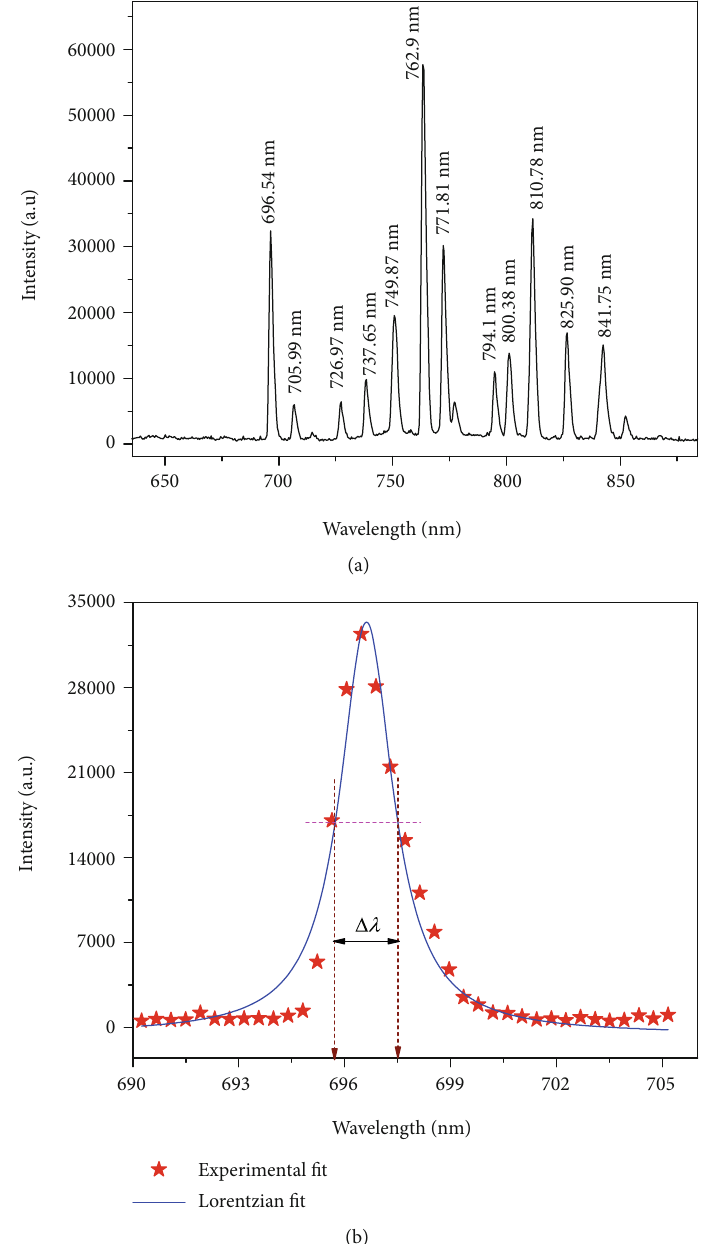
Figure 3: Spectrum of the discharge at 5.5kV with a frequency of 20kHz in argon ( flow rate = 3 L/min